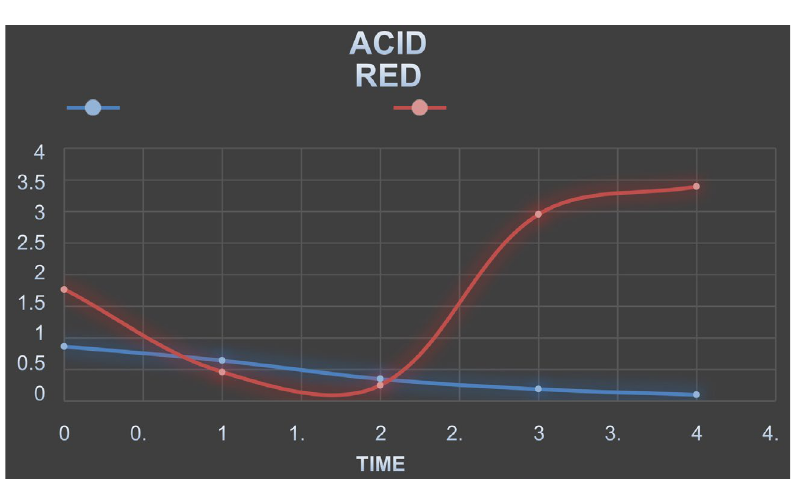
Fig. 6. Acid Table 6. Absorbance of enzyme at different pH pH Absorbance at 450 nm Control